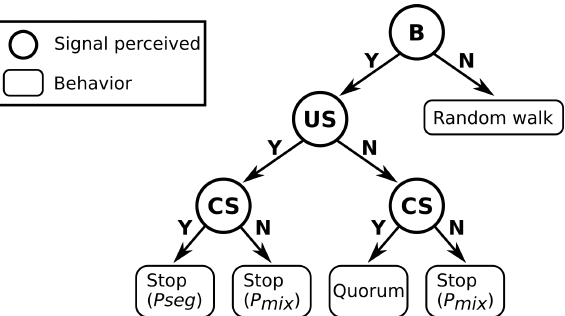
Figure 8. Decision tree describing the reactive behavior implemented by the robots. In circles are the signals that can be perceived by the robot, with B the beacon signal of the aggregating device, US the unconditional stimulus, and CS the conditional stimulus ( B , US , and CS are implemented in simulation as acoustic messages that can be perceived by all robots at once). In rounded rectangles are the subroutines that can be executed, with mainly the random walk, the quorum, and the decision to stop any motion with a probability that can either depend on any (self or opposite team) nearby robots ( P mix ) or on the nearby robots of the same team only ( P seg ). This behavior does not require memory at the individual level as it is only based on the execution of different subroutines controlled by the current perception of the